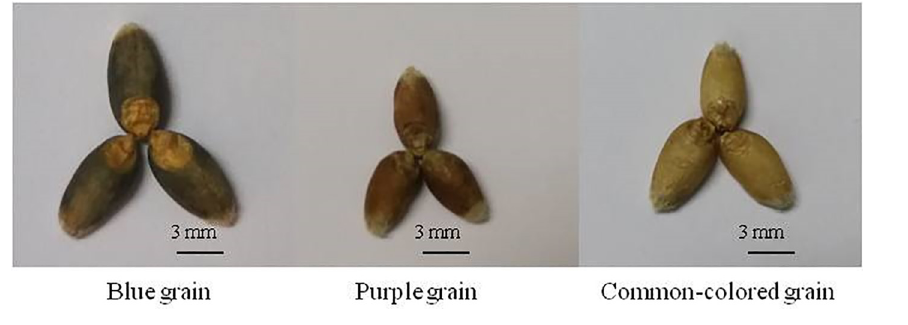
Fig 1. The color of three types of wheat